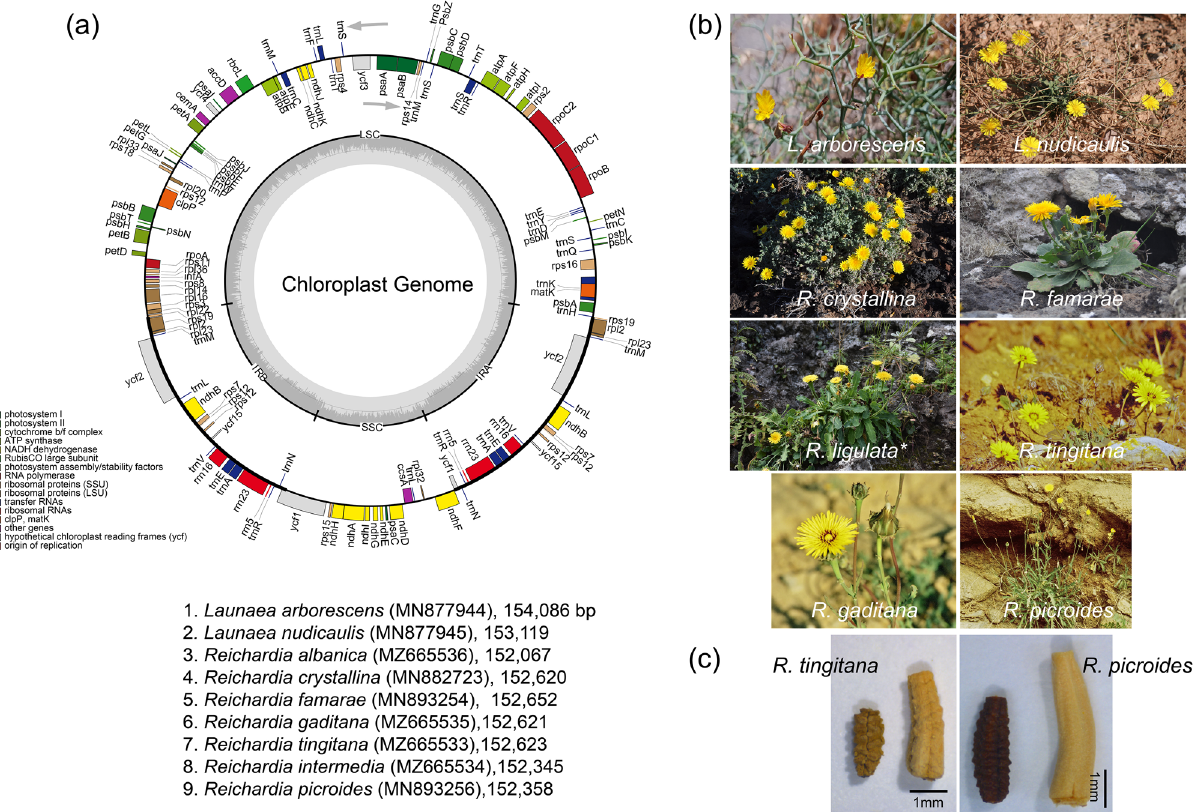
Figure 1. ( a ) Gene map of the chloroplast genomes of seven Reichardia and two Launaea species sequenced in this study. The genes inside and outside of the circle are transcribed in the clockwise and counterclockwise directions, respectively. Genes belonging to different functional groups are shown in different colors. The thick lines indicate the extent of the inverted repeats that separate the genomes into small single copy (SSC) and large single copy (LSC) regions. ( b ) Photos of Reichardia and Launaea species. ( c ) Photos of outer (left) and inner (right) heteromorphic achenes in R. tingitana and R. picroides . Photo credit: José A. Mejías ( L. nudicaulis,